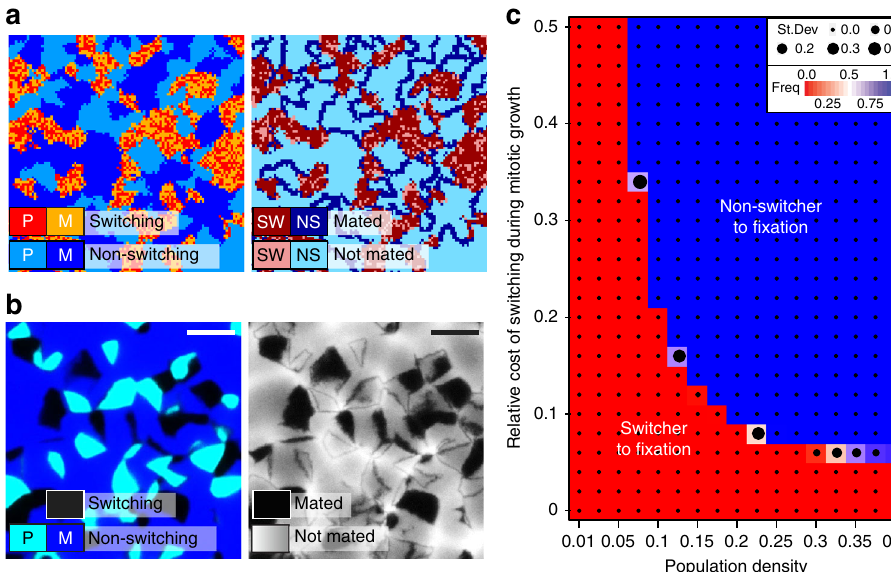
Fig. 4 Growth in structured environments greatly bene fi ts switchers during mating. a Example of simulation. Left panel shows result of one round of asexual growth of simulation that shows the mating type of switcher (SW) (red and orange for P and M, respectively) and non-switchers (NS) (light and dark blue). The right panel shows, which cells mated and contributed to the next generation. b Left panel shows recoloured composite fl uorescence image of a mixture between two labelled non-switching P and M strains (NS; two shades of blue; mCherry and GFP, respectively) and an unlabelled switching strain (SW; no fl uorescence, i.e. black) plated out at low density on low-N medium. Right panel shows the same plate after iodine vapour was applied to stain mated cells (black). Switcher patches are fully mated, non-switchers can only mate at the edge of a patch similar to simulations in a . Scale bar: 0.5 mm. c Heat map summarizing the results from cellular automata simulations in a 40,000-cell grid after 500 transfers or when either switchers or non- switchers went extinct, with varying levels of population density and cost of switching. Under low densities or with little cost of switching, non-switchers cannot invade in the population. Stable polymorphism is not observed. Colour indicates average ratio of non-switchers from 10 replicate runs with standard deviation indicated by the size of the black